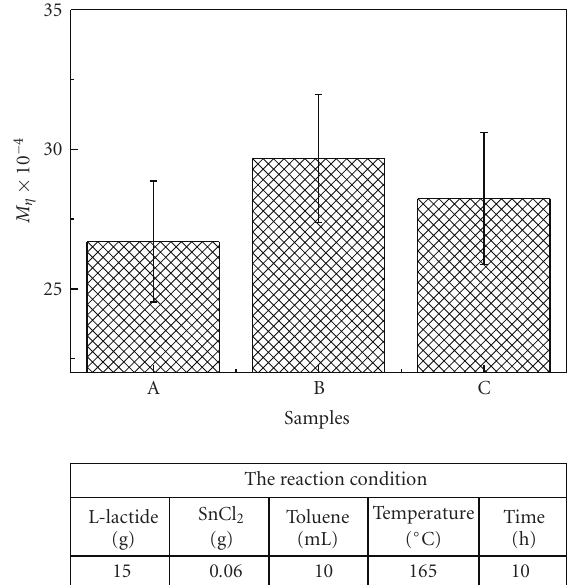
Figure 6: The e ff ect of antioxidant on M η . A: without antioxidant; B: adding antioxidant before polymerization; C: adding antioxidant 5 hours during polymerization processing.